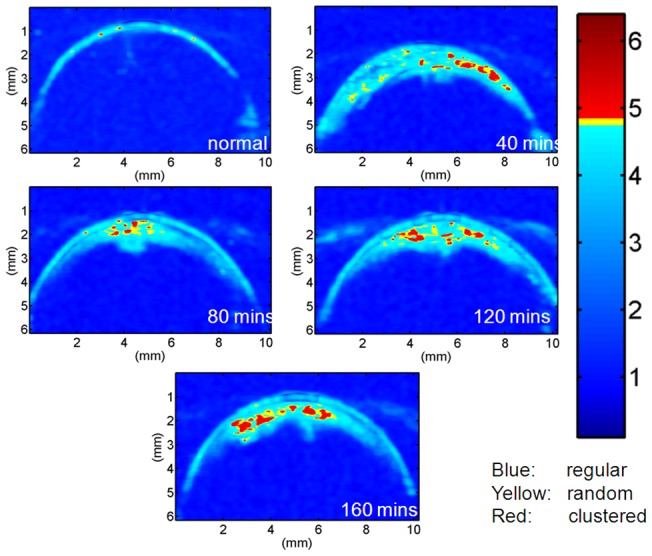
Representative entropy images of the porcine lens at different stages of cataract formation.